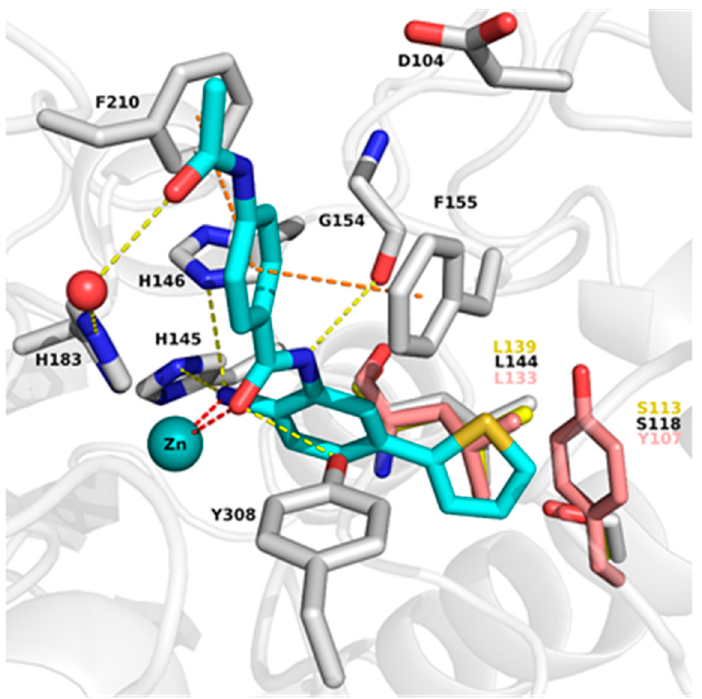
Figure 2. Comparison of the binding pocket of HDAC2 (white carbon atoms) with HDAC1 (yellow carbon atoms) and HDAC3 (salmon carbon atoms). Only the part of the foot pocket that differs in HDAC3 compared to HDAC1 and HDAC2 is shown for all three isoforms, and residues are labeled in the same colors as the carbon atoms. The protein backbone is shown as white ribbon. The zinc ion is shown as cyan sphere and the water molecule as red sphere. The ligand is shown as sticks with cyan carbon atoms. Protein–ligand interactions are shown as dashed lines: zinc coordination in red, hydrogen bonds in yellow, and aromatic interactions in orange.